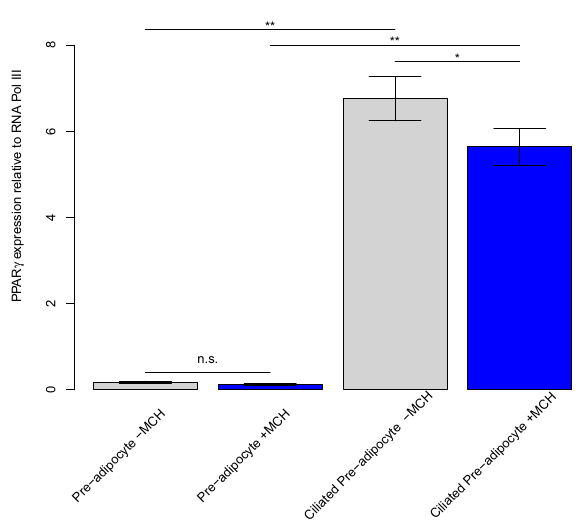
Figure 6. Expression of ppar-γ compared to reference gene, analyzed by qPCR. Expression is significantly increased in differentiating ciliated 3T3-L1 cells versus non-ciliated 3T3-L1 cells. Furthermore, 6 h 100 nM MCH treatment results in decreased expression at both timepoints of differentiation (n = 3). * p < 0.05; ** p < 0.01; *** p < 0.001; n.s. not